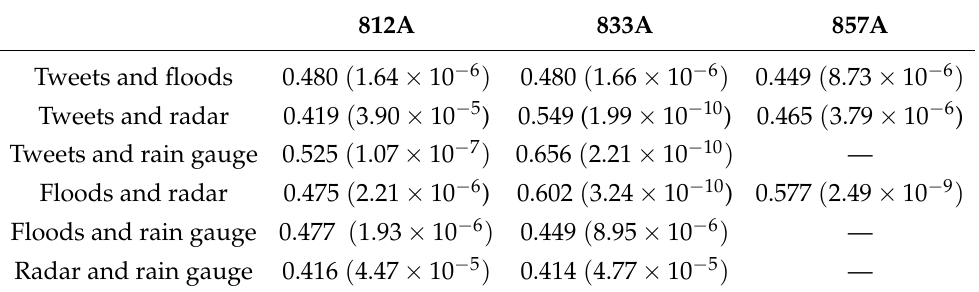
Table 2. Spearman’s correlation coefficient ρ and respective p -value (in